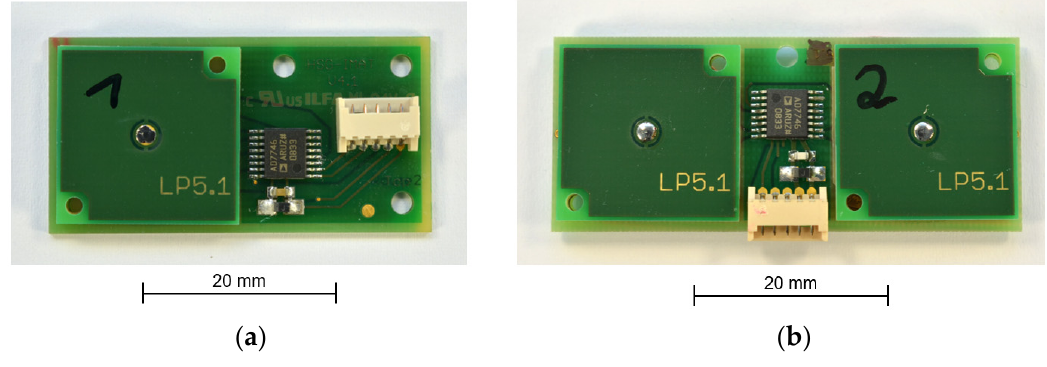
Figure 16. PCB variant of the sensor: ( a ) PCB1; ( b ) PCB2.